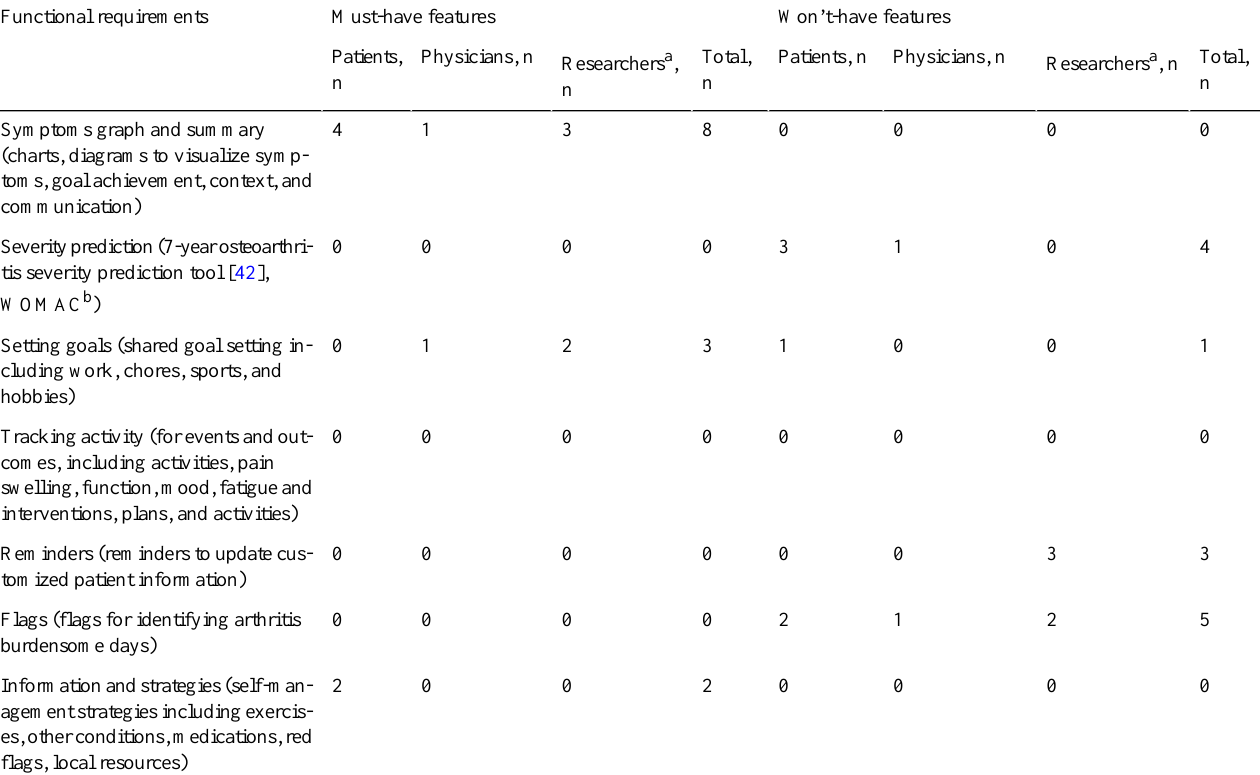
Table 6. Session 3 dot voting results: revised functional requirement categories and summary of must-have and won’t-have features.